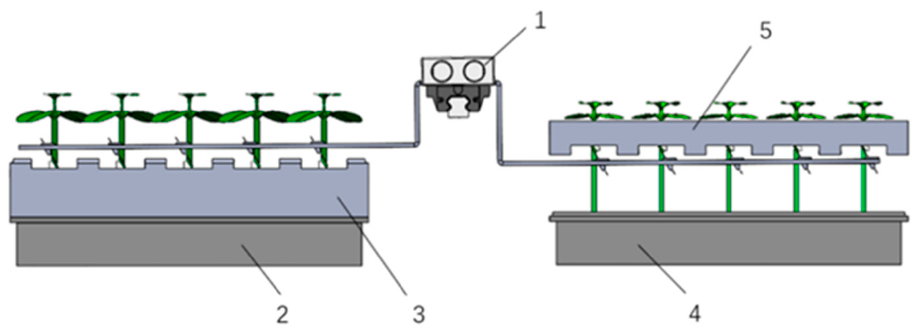
Figure 12. Schematic diagram of cutting process for rootstock and scion. 1. Cutting device; 2.